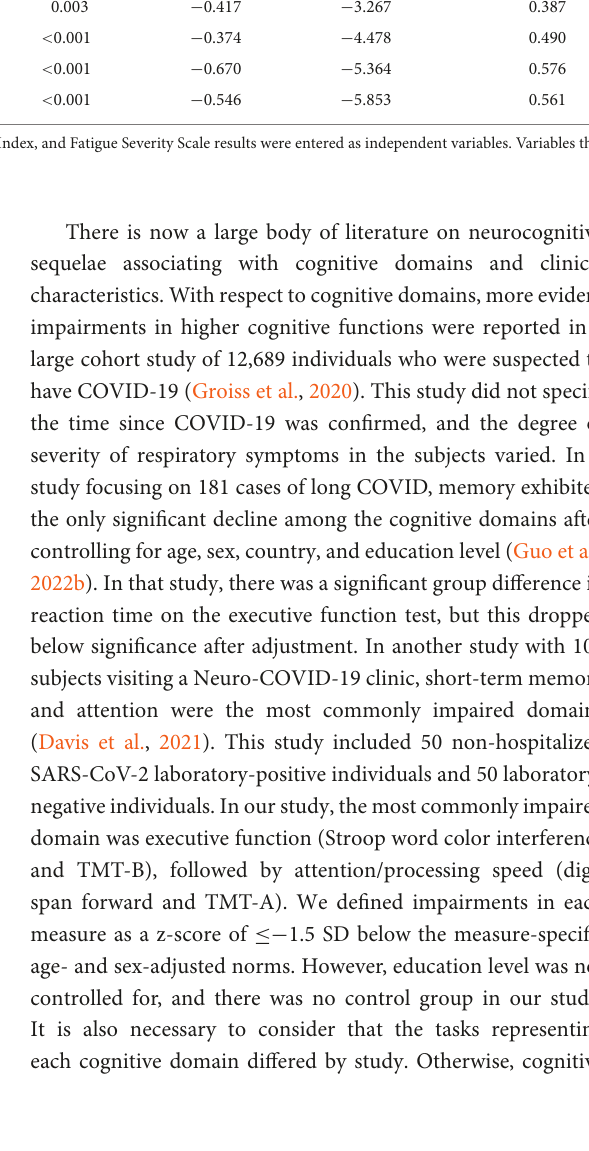
TABLE 5 Linear regression results for cognitive function by age and other clinical characteristics.